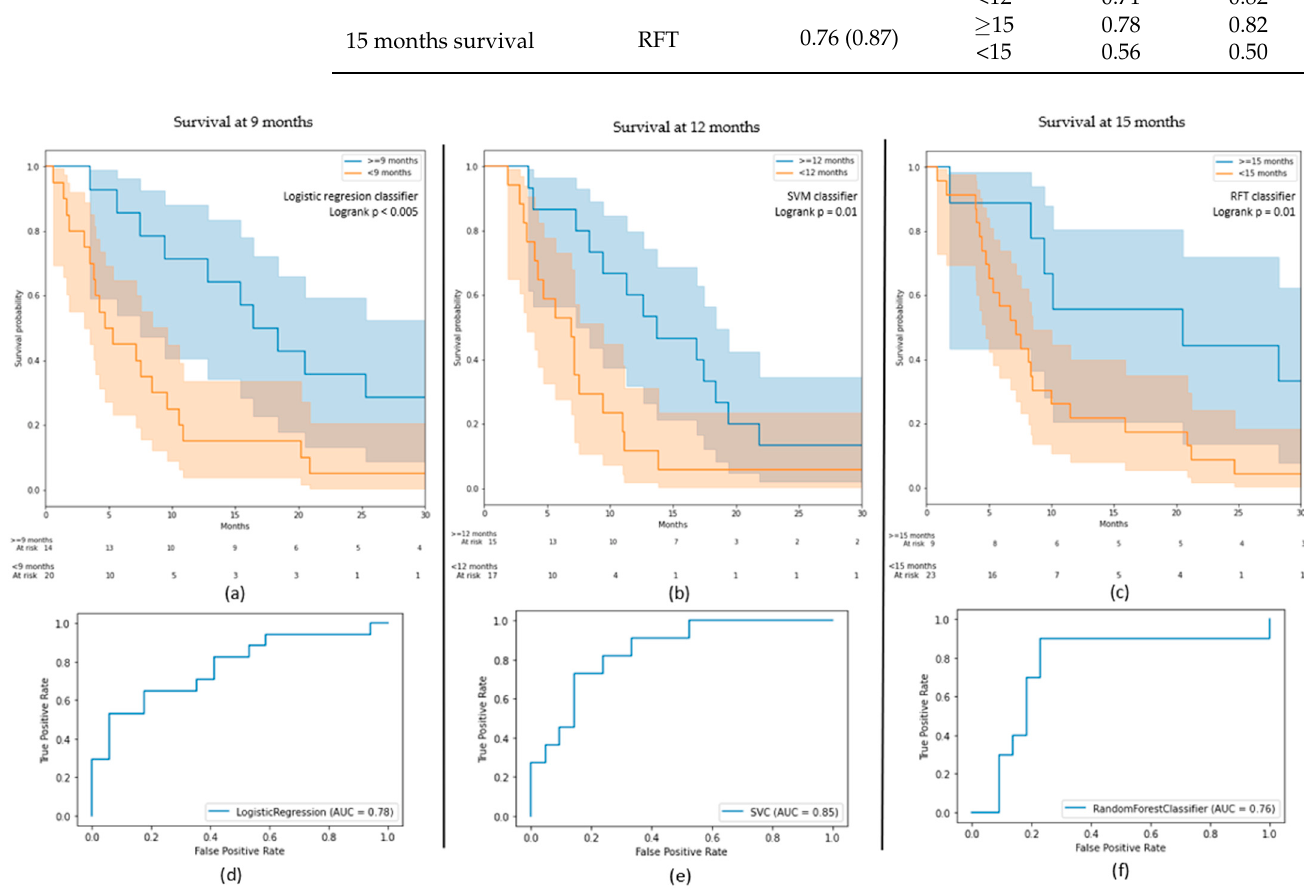
Figure 3. ( a – c ) Kaplan–Meier curves for the 9-, 12-, and 15-month models; ( d – f ) receiver operating characteristic (ROC) curves of the results on the test sets for the 9-, 12-, and 15-month